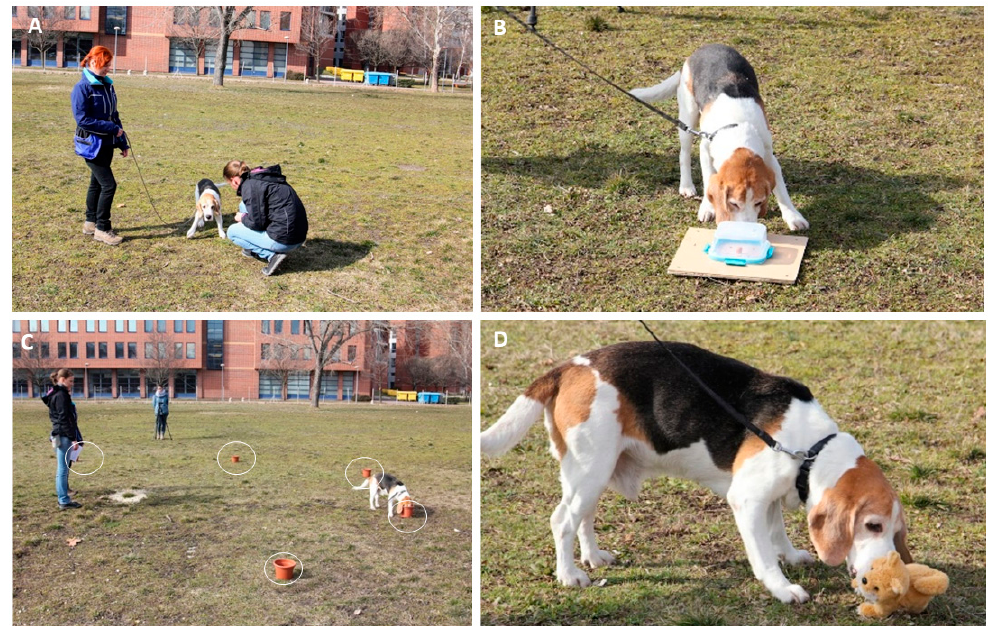
Figure 1. Example images from four sub-tests: greeting ( A ), problem box ( B ), memory (the pots are highlighted with yellow ovals) ( C ), novel object (toy dog, D ). The persons identifiable in the images provided written consent for publication.